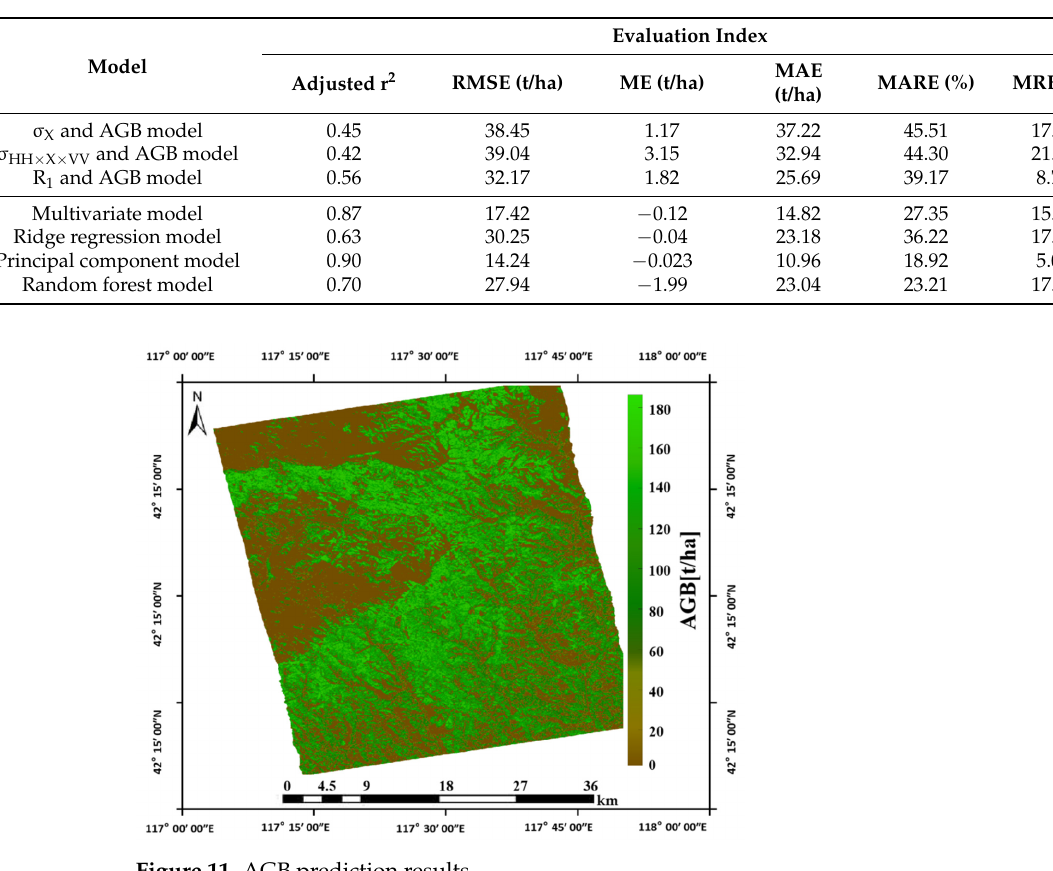
Table 13. Model evaluation index.